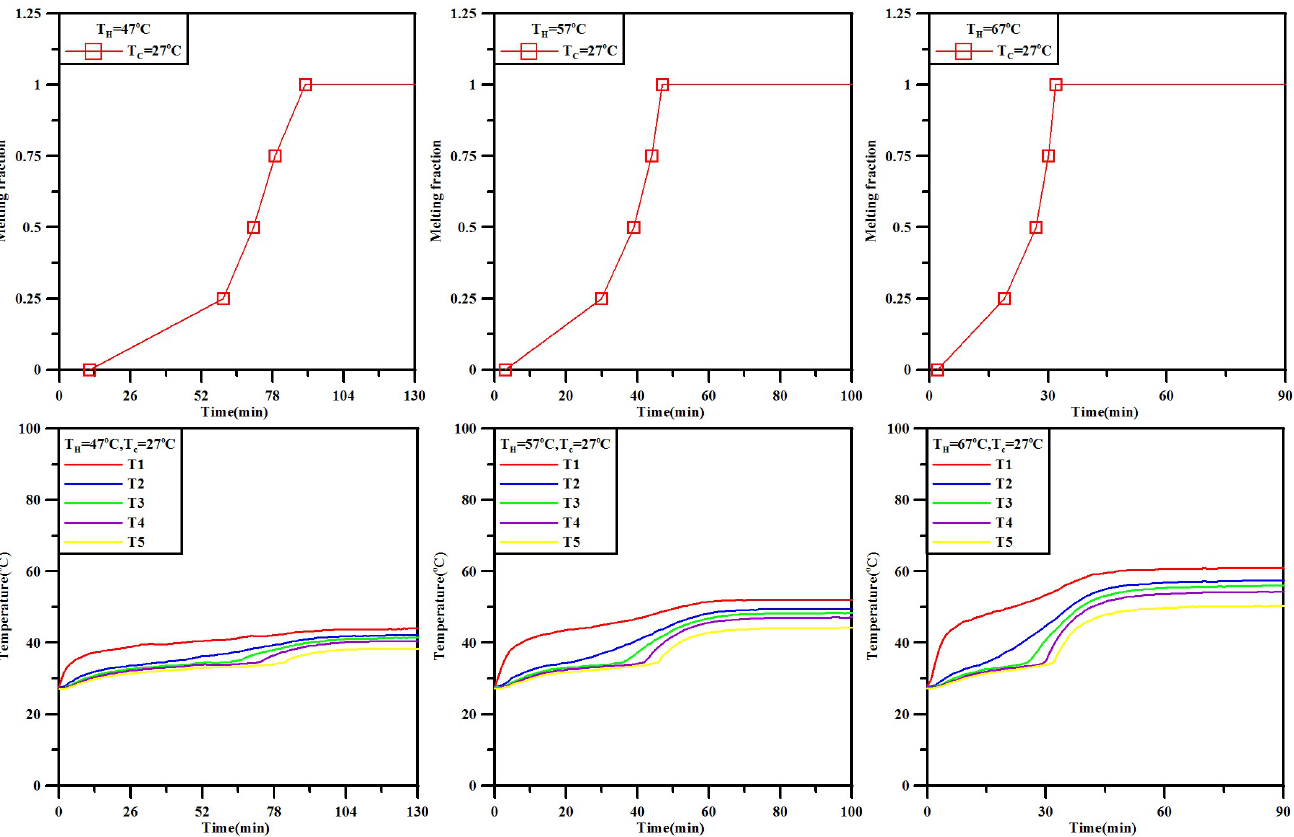
= 27 ◦ C and various T C H